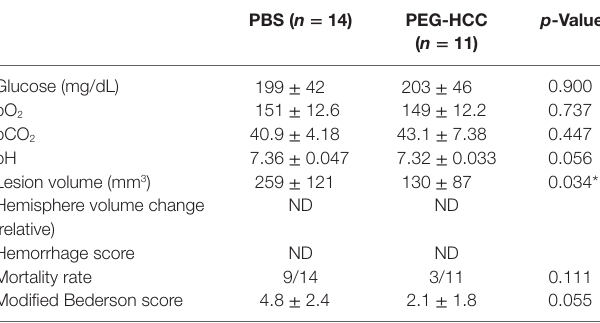
TaBle 2 | Results of hydrophilic carbon cluster, conjugated to poly(ethylene glycol) (PEG-HCC) treatment compared with controls in hyperglycemia after 120 min occlusion and assessment at the end of experimental period.